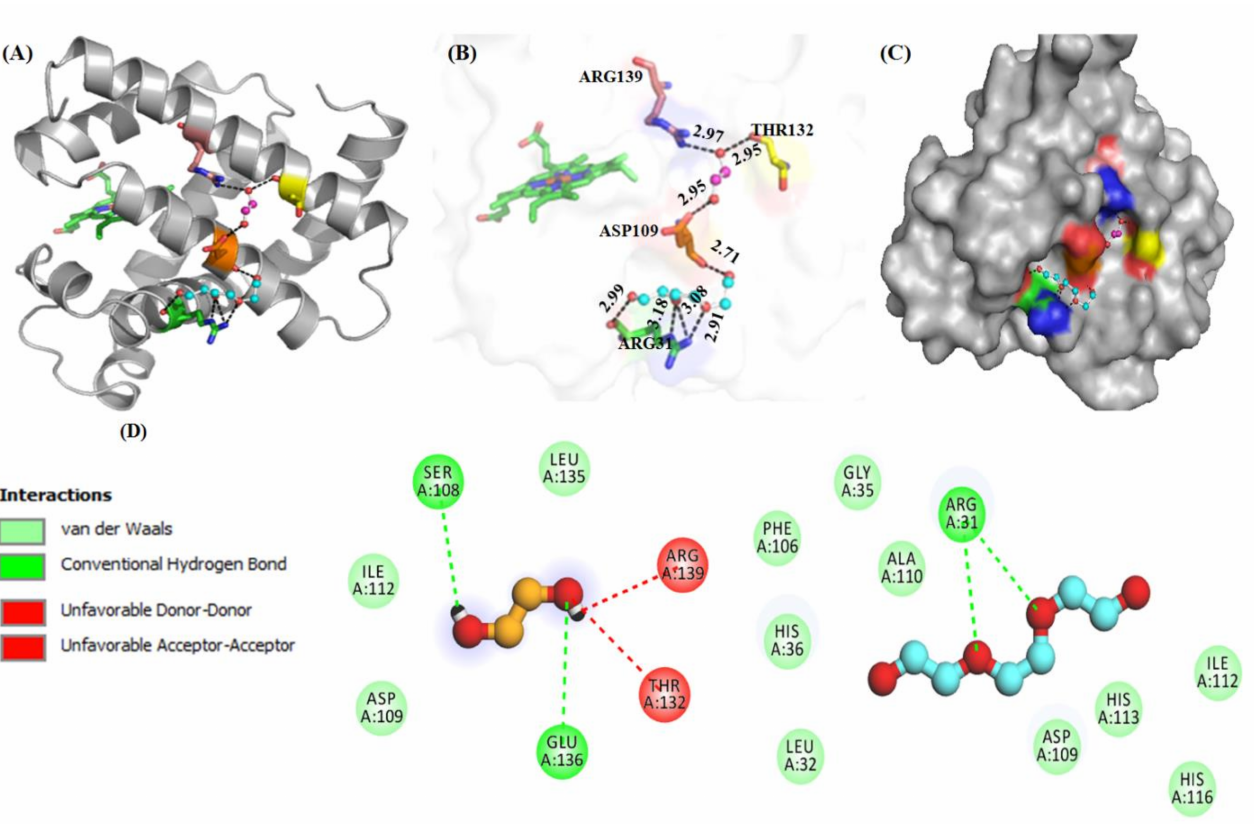
Figure 4. ( A , B ) Interactions of crowders (i) PEG 400 (ball and stick model, red-blue) (ii) EG (ball and stick model, red-pink) with amino acid residues of Mb (cartoon model, gray). ( C ) Surface view of Mb and the binding site for PEG and EG on the protein. ( D ) 2D representation of various types of interactions between amino acid residues and crowders (PEG 400 and